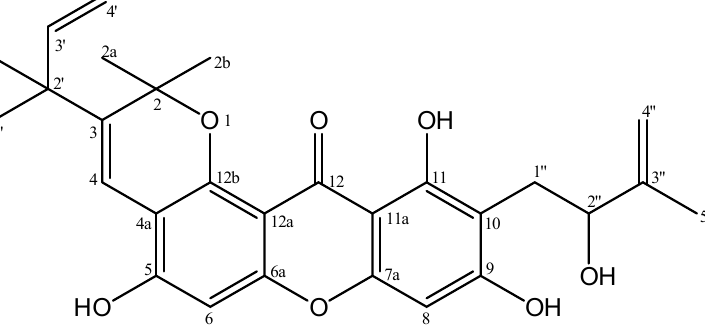
Figure 1. Structures of 5,9,11-trihydroxy-10-(2 ″ -hydroxy-3 ″ -methylbut-3 ″ -en-1-yl)-2,2- dimethyl-3- (2 ′ -methylbut-3 ′ -en-2 ′ -yl)-2H , 12H - pyrano[2,3-a]xanthen-12-one.